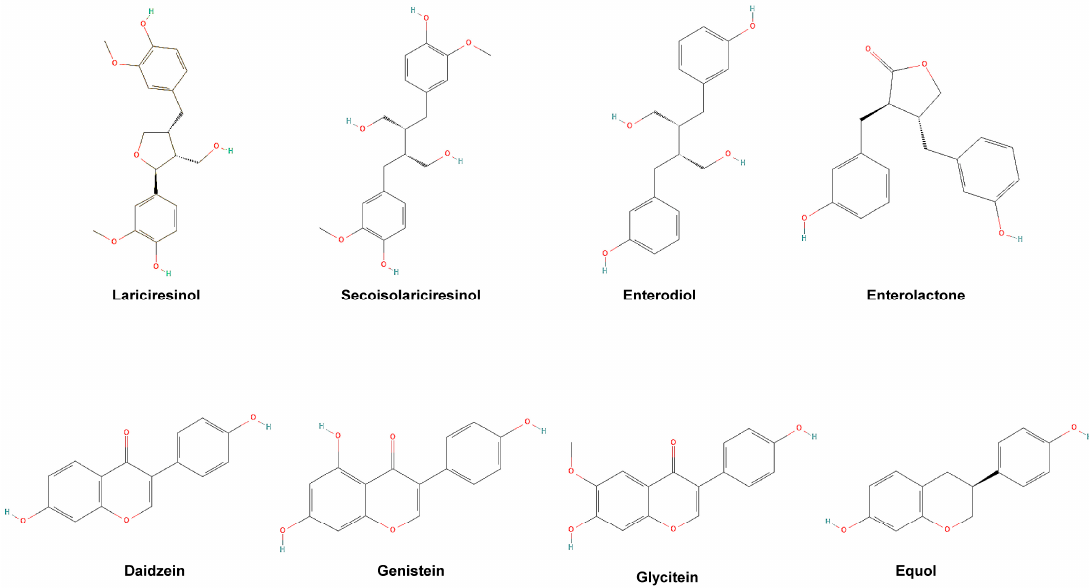
Figure 2. Chemical structures of the analyzed phytoestrogens in the study. Collected with permission from PubChem, URL: pubchem.ncbi.nlm.nih.gov [29].